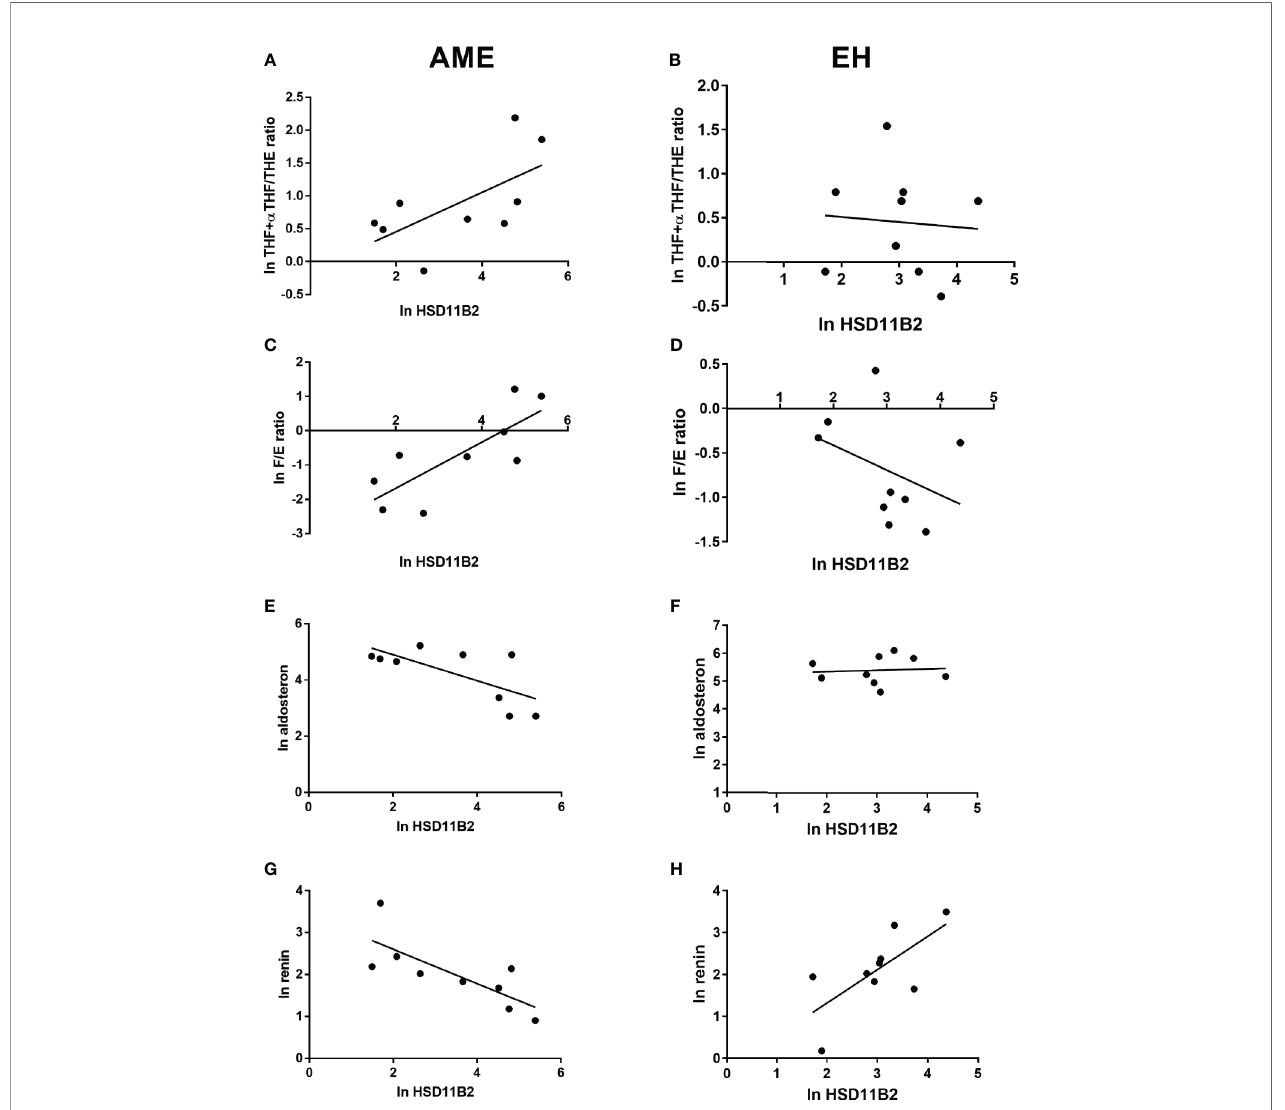
FIGURE 6 | HSD11B2 exosomal mRNA levels and steroid ratio and aldosterone and renin correlations in AME subjects (on the left) and in EH patients (on the right). 11 b -HSD2 exosomal mRNA showed a positive correlation with THF+allo-THF/THE ratio in AME subjects, r = 0.6266, p -value = 0.0710 (A) and an inverse correlation in EH patients, r = − 0.07793, p -value = 0.8420 (B) . Similar trend was found between 11 b -HSD2 exosomal mRNA and F/E ratio in AME, r = 0.7825, p -value = 0.0127 (C) and inverse in EH, r = − 0.3762, p -value = 0.3184 (D) . On the contrary, an inverse and signi fi cant correlation was found between 11 b -HSD2 exosomal mRNA and aldosterone and renin in AME and a positive signi fi cance for renin in EH, r = − 0.6921, p -value = 0.0388 (E) and r = − 0.7649, p -value = 0.00164 (G) , r = 0.692, p -value = 0.039 (H) , respectively. No correlation was found in EH for 11 b -HSD2 exosomal mRNA and aldosterone, r = 0.081, p -value = 0.8359 (F)